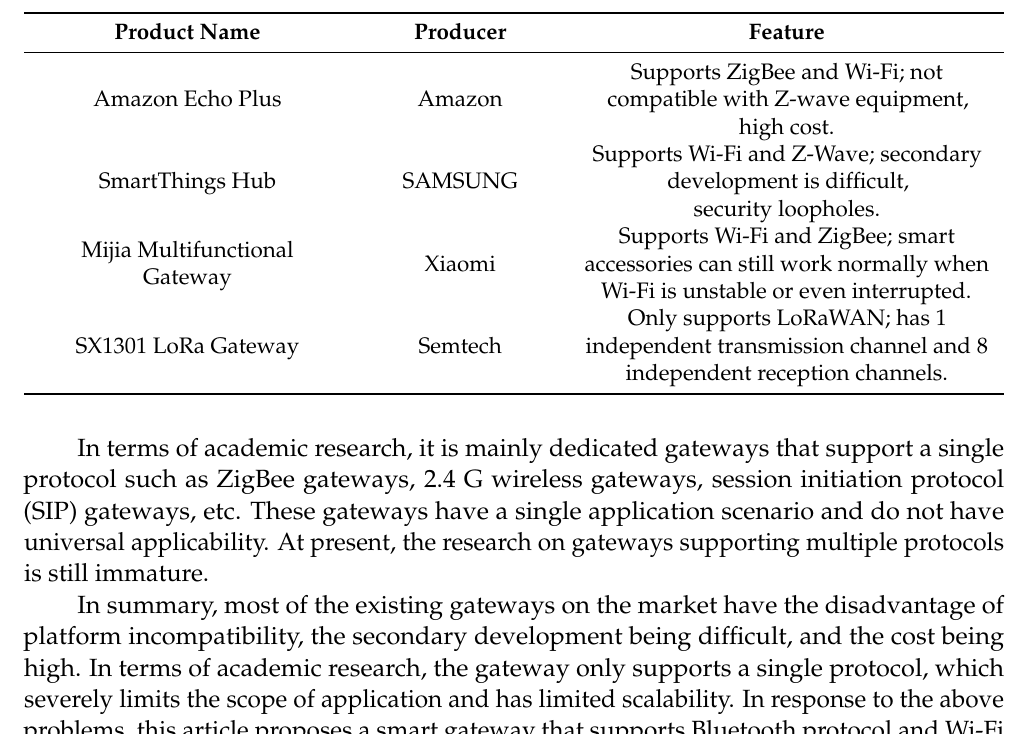
Table 1. Commercial Application Gateway Product Performance